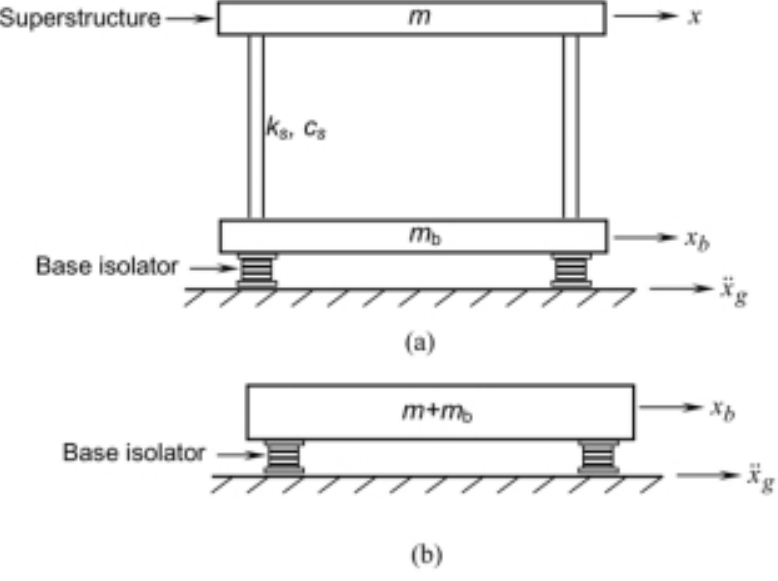
Fig. 1. Model of base-isolated structure with flexible and rigid superstructure.